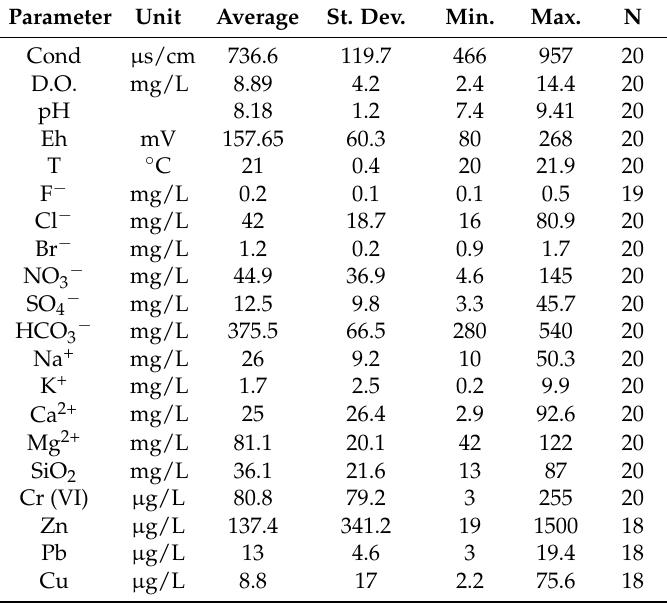
Table 1. Descriptive statistics of chemical analyses of the dry period of 2012. Parameter